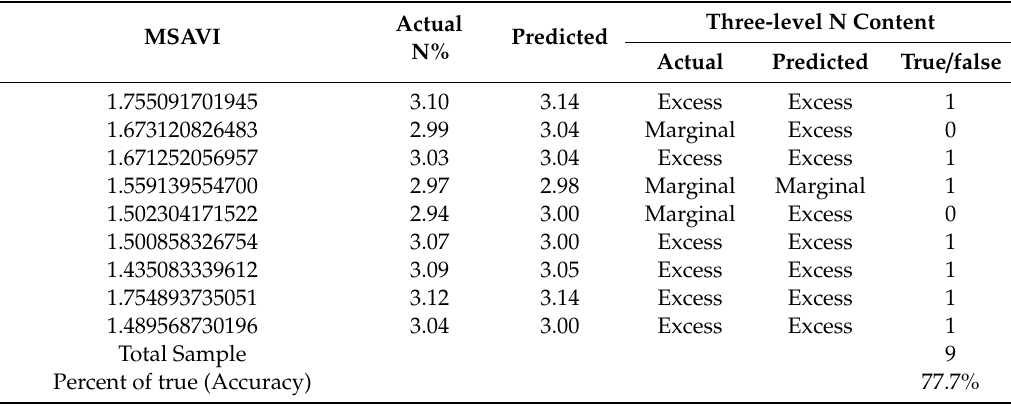
Table 13. Classification accuracy for the percentage of oil palm leaf nitrogen